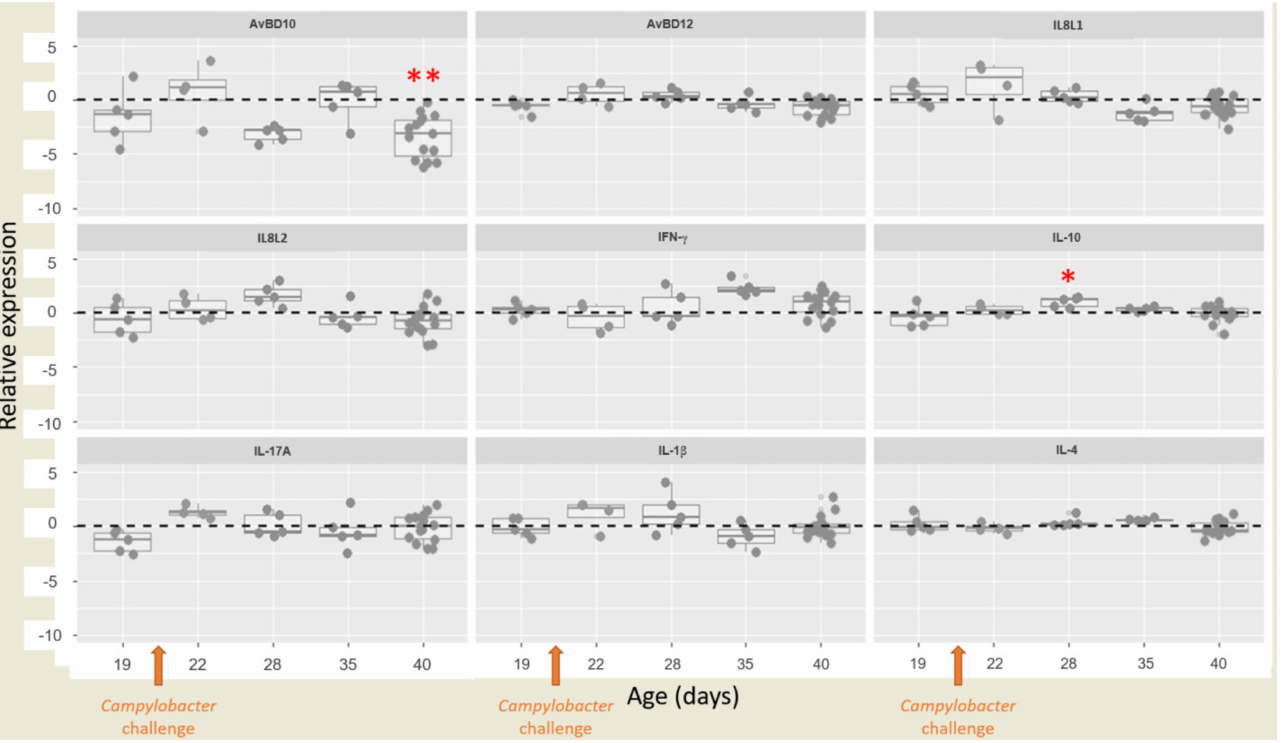
Figure 4. Relative gene expressions of cytokines, chemokines and AMPs in caecum. Relative gene expression represents log 2 ratio vaccinated/placebo. Values > 0 (above the dotted black line) represent relative over-expressions of cytokine, chemokine or AMP genes in the caecum of vaccinated chickens compared with the placebo group while values < 0 (below the dotted black line) represent relative sub-expressions of cytokine, chemokine or AMP genes in the caecum of vaccinated chickens compared with the placebo group. Student’s parametric test was used when the normality and homogeneity criteria of the variances were validated (checked by the Shapiro–Wilk normality test and Bartlett’s test respectively); otherwise, the non-parametric Mann–Whitney test was used. Significant differences between 2 − ∆ Ct values of the vaccinated and placebo groups are indicated by asterisks in red (* p < 0.05, ** p < 0.01) for the expression of each gene at the corresponding time points. The genes evaluated were interferon (IFN)- γ , interleukin (IL)8-like(L)1, IL8L2, IL-1 β , IL-4, IL-10, IL-17A, antimicrobial peptide avian β -defensins 10 (AvBD10) and AvBD12. Table 3. Number of sequences and OTUs per step. Ten chickens (five in the vaccinated group and five in the placebo group) on D19 and D40 and eight chickens (four in the vaccinated group and four in the placebo group) on D22 were tested. D19 D22